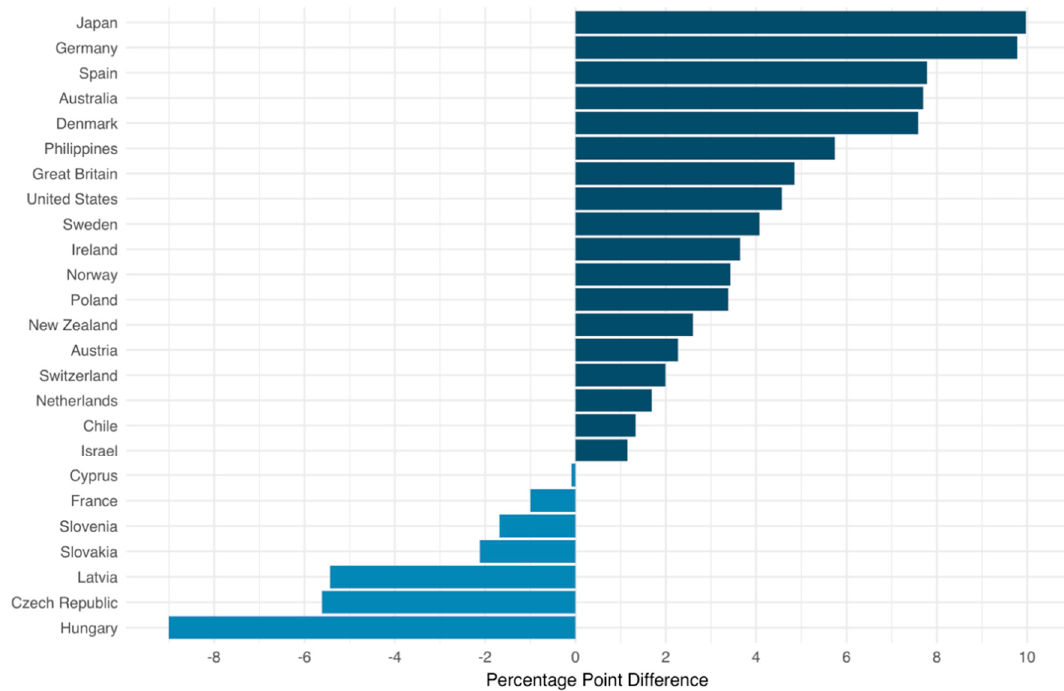
Figure 2. Percentage point change in religious heterogamy by country, ISSP 1998–2008.